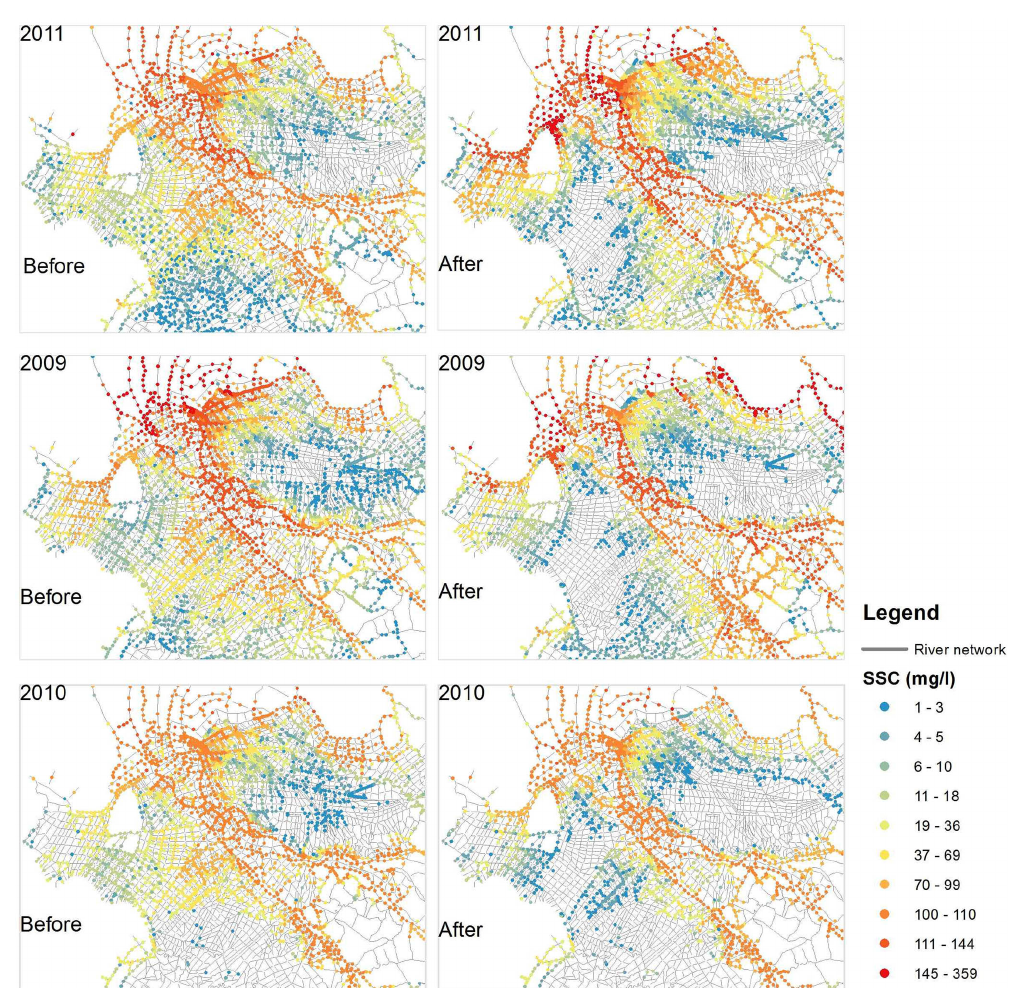
Figure 8. SSC distribution in the VMD for three floods: SSC distribution before (left panel) and after (right panel) sluice gate